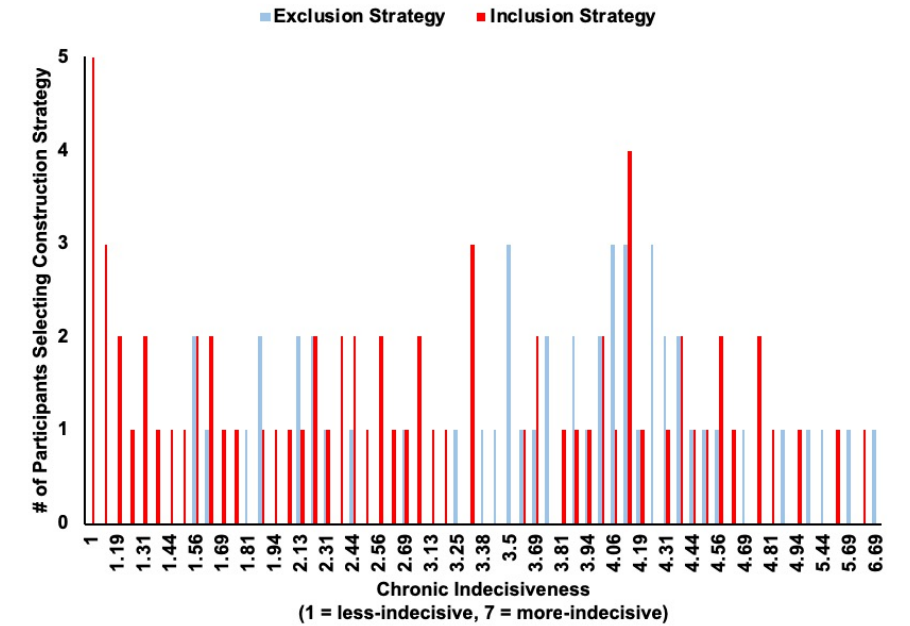
<Figure 1> Study 1: Number of Participants Selecting an Inclusion vs. an Exclusion Strategy Depending on the Level of Chronic